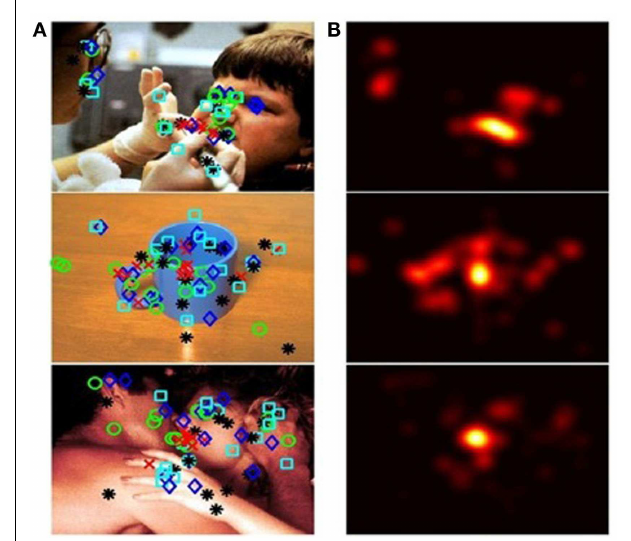
FIGURE 1 | Generation of affectively salient ROIs. Column (A) from top to bottom, images categorized as: negative, neutral, or positive. Shapes overlying the images denote spots that participants identified, via mouse clicks, as affectively salient. Different shapes denote participants’ order of preference. Column (B) affective salience maps, generated from participants’ responses to images in column (A)